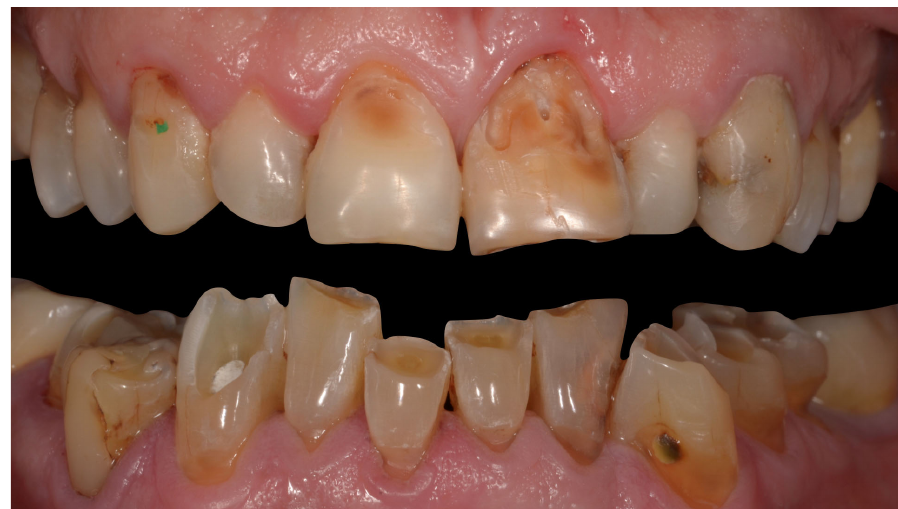
Figure 3. Wide enamel–dentine wears, associated with non-carious cervical lesions in a 60-year-old male CeD patient.